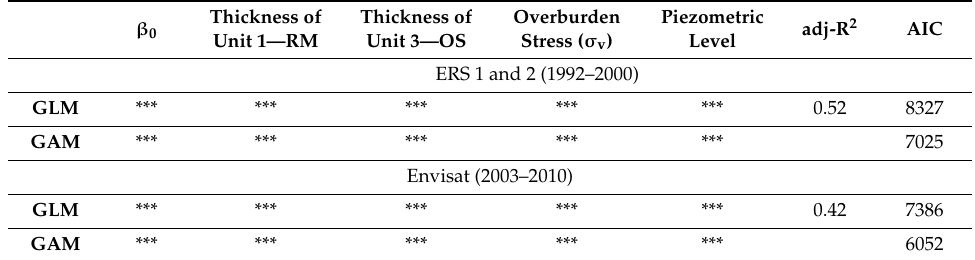
Significance codes: *** = 0.